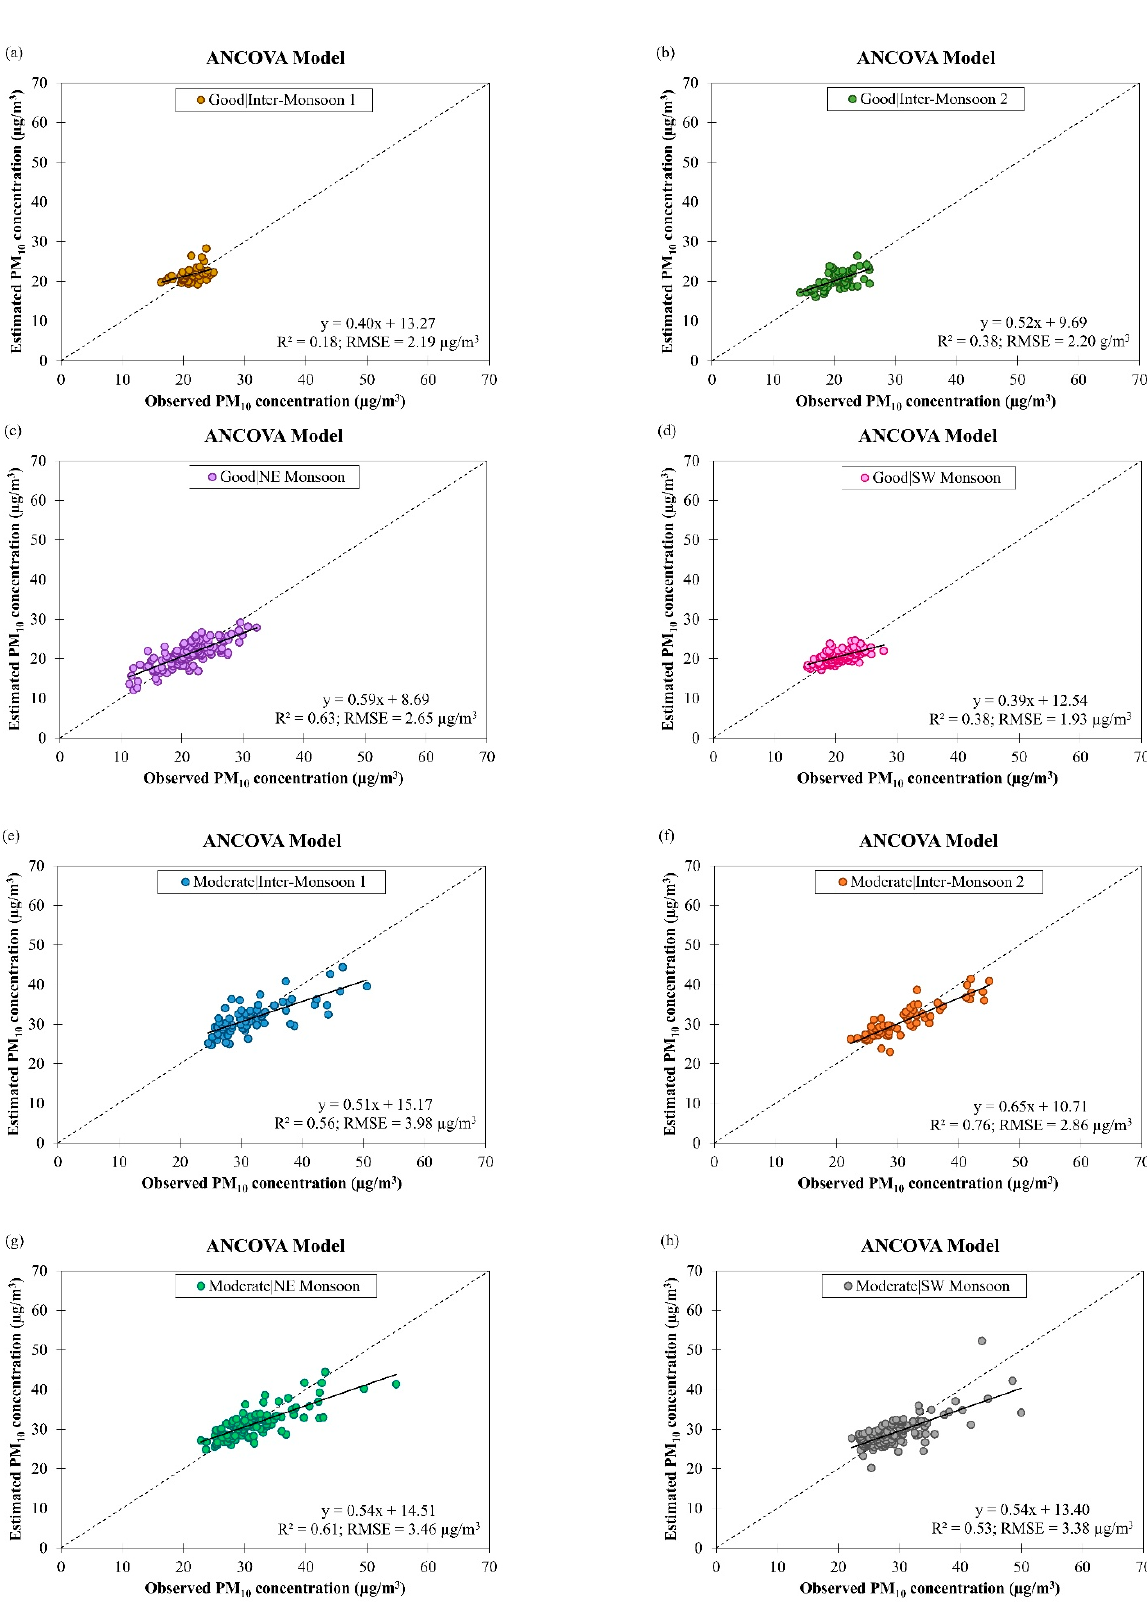
Figure 11. Scatter plots of estimated daily PM 10 concentration against observed daily PM 10 concen- tration by ANCOVA model for ( a – d ) good and ( e – h ) moderate air quality conditions during different monsoon seasons in Singapore from March 2016 to February 2018.